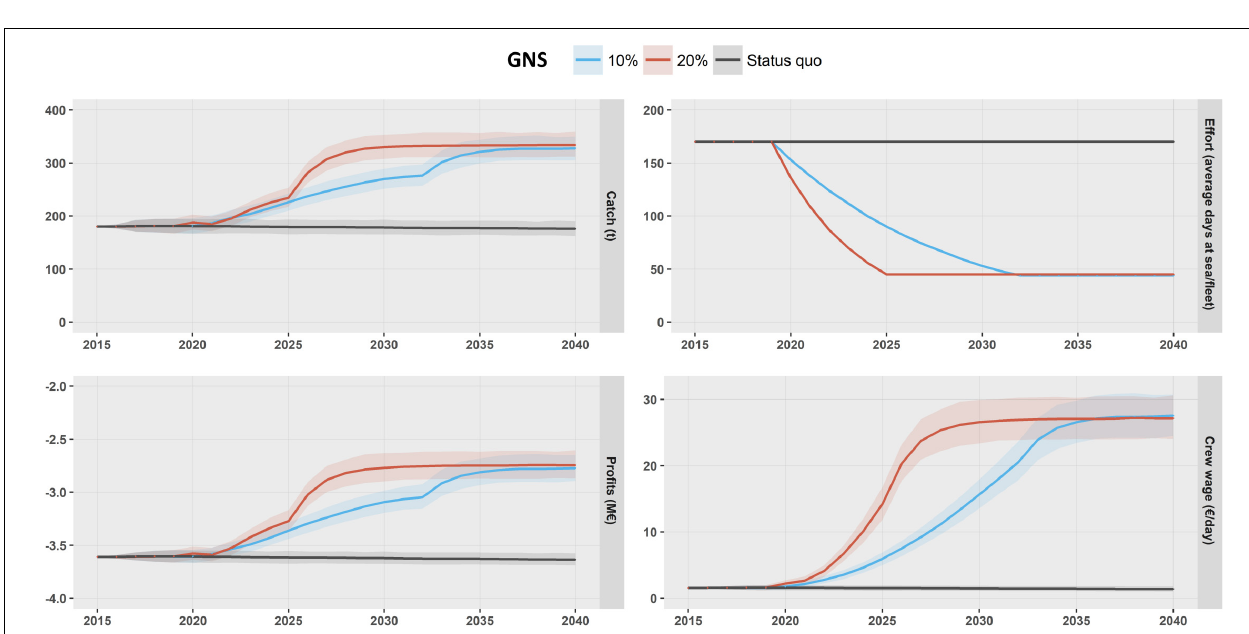
FIGURE 3 | Results of the bioeconomic model of catch (t), effort (average days at sea), profits (M€), and crew wage (€/day) for trawl fleet (OTB) under Scenario 0: status quo ; Scenario 1: 10% annual reduction; and Scenario 2: 20% annual reduction.